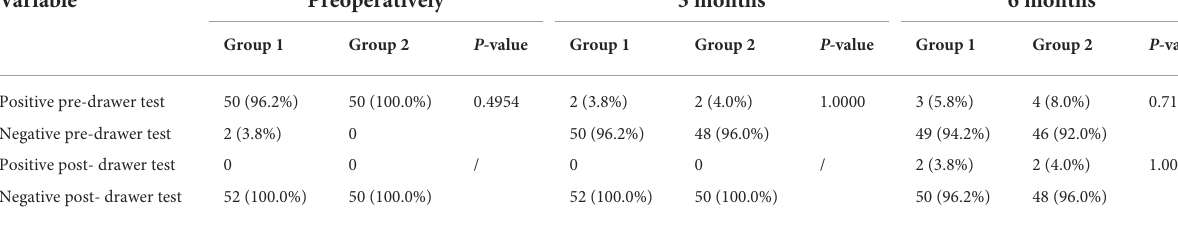
TABLE 7 Drawer test